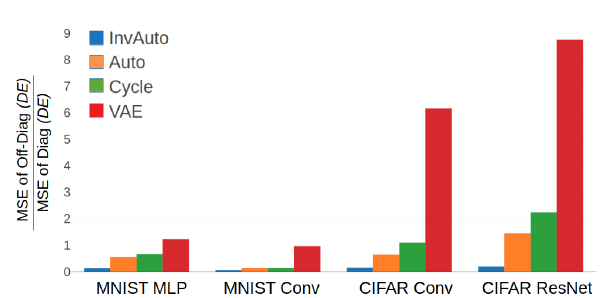
Figure A2. Comparison of the MSE of the off-diagonal of DE − I for InvAuto, Auto, Cycle, and VAE on MLP, convolutional (Conv), and ResNet architectures and MNIST and CIFAR dataset.